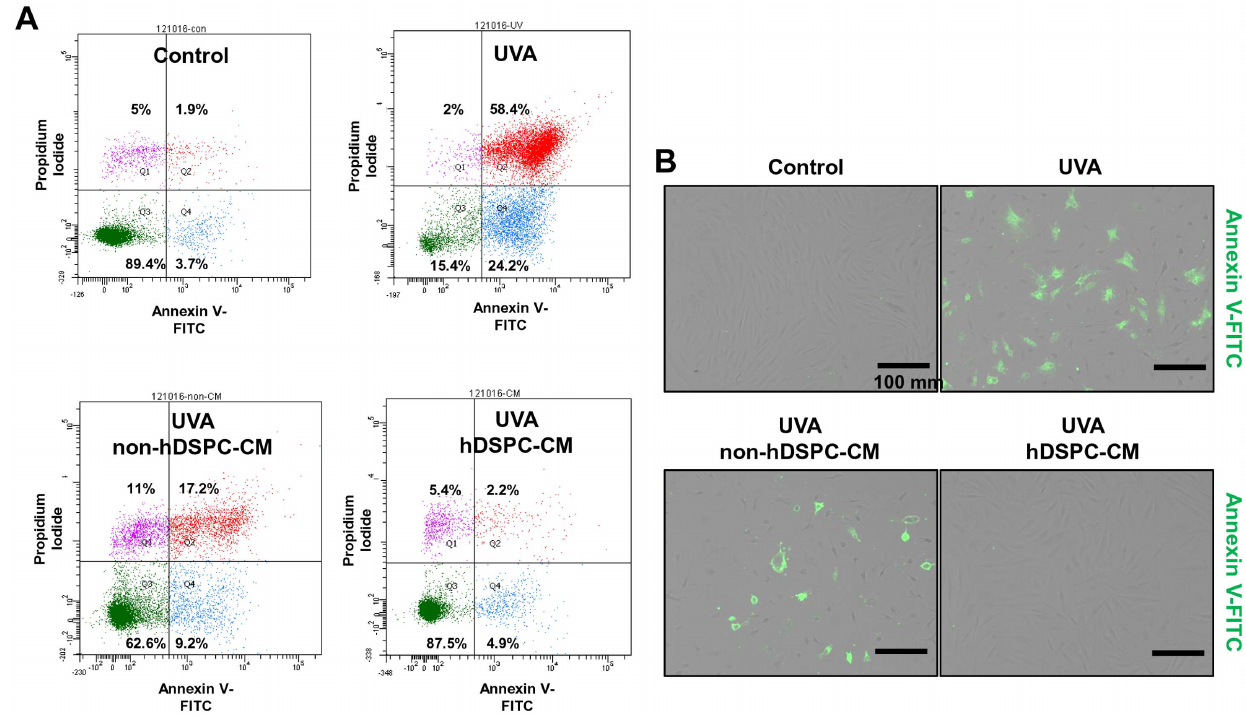
Figure 4. UVA irradiation-induced apoptotic cells were recovered by hDSPC-CM. NHDFs were irradiated with UVA (6 J/cm 2 ) and incubated with either hDSPC-CM or non-hDSPC-CM for 24 hr and labeled with Annexin V-FITC and propidium iodide (PI). The distribution of apoptotic cells was analyzed using FACSAria II instrumentation. Only PI positive cells are dead (Q1). Cells showing Annexin V and PI double-labeling represent the stage of late apoptosis (Q2). Live cells were not labeled with Annexin V and PI (Q3), whereas Annexin V-labeled cells (Q4) represent the early stage of apoptosis. Ten thousand cells were analyzed for each condition (A). Apoptotic cells labeled with Annexin V under fluorescence microscopy to examine the effects of hDSPC-CM (B). The data are representative of three independent